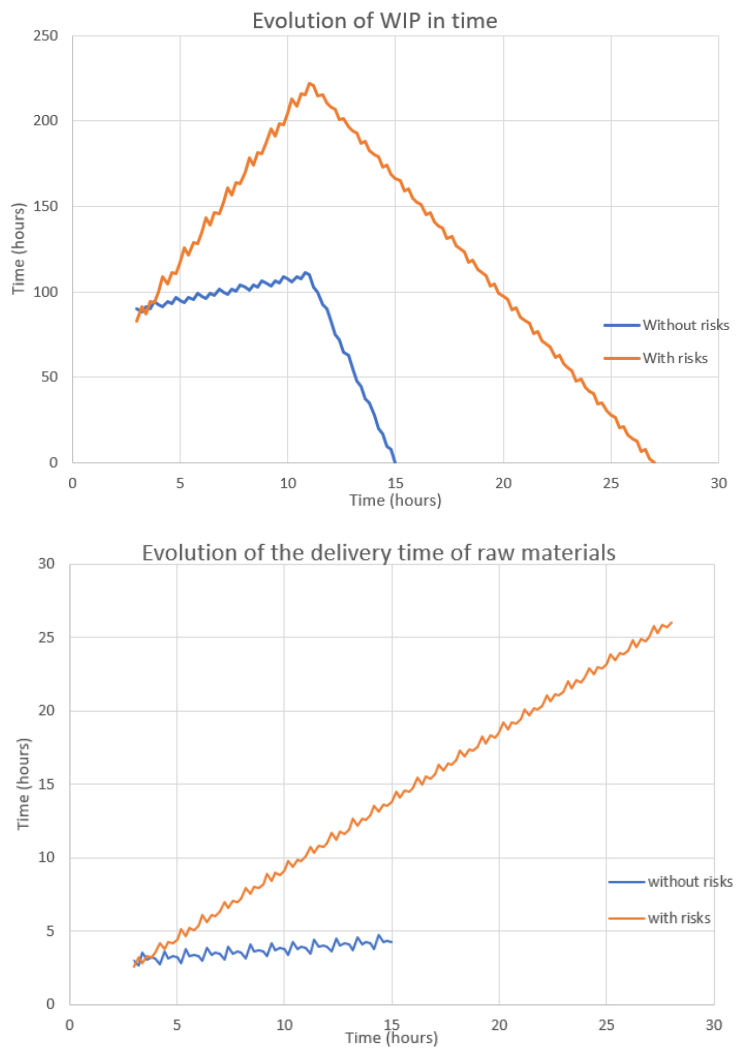
Figure 15. Evolution of JaamSim KPI's with and without risk management.